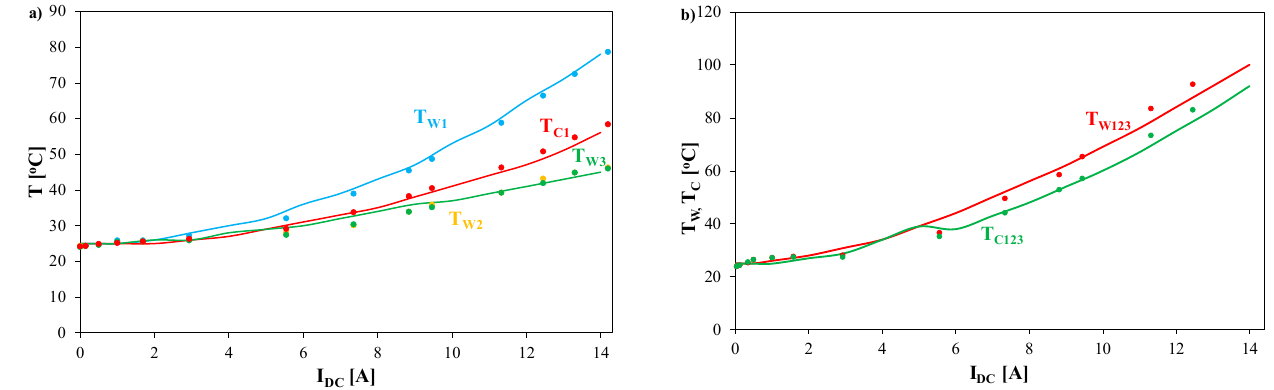
Figure 14. Dependence of the temperature of the inductor components on the direct cur- rent ( a ) when power is dissipated in one winding, ( b ) when the power is dissipated in three series ‐ connected windings.